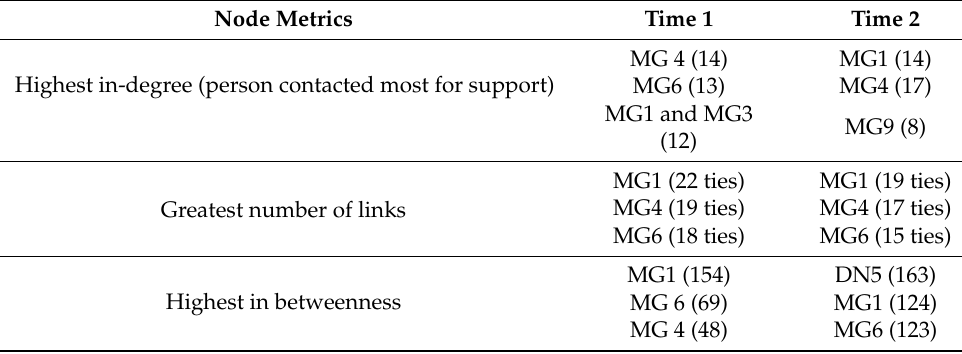
Table 3. Node-level metrics for